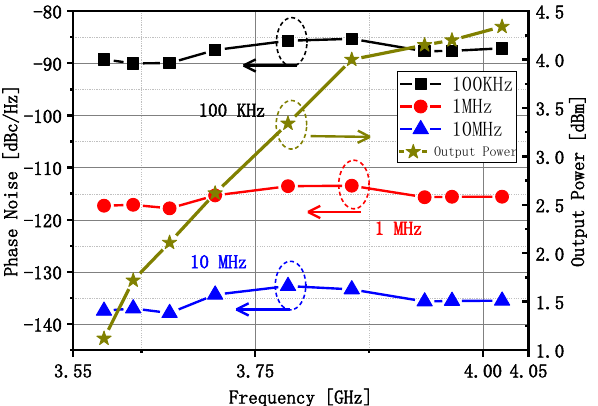
Figure 13. The phase noise and output power when the output signal frequency is 3.584 GHz to 4.021 GHz.